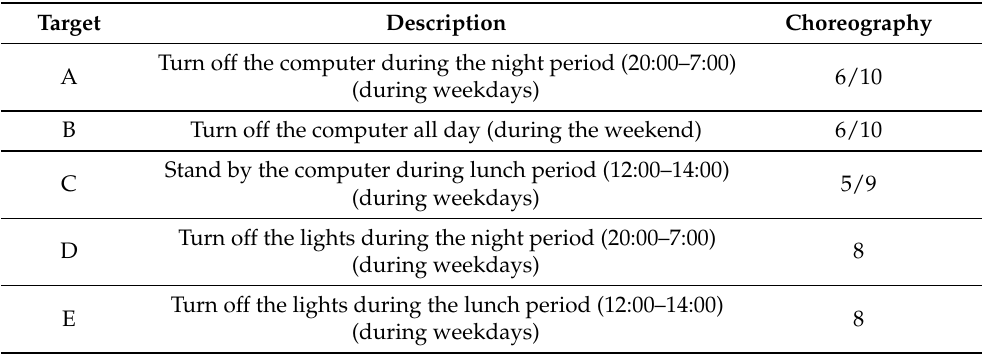
Table 12. Identified targeted